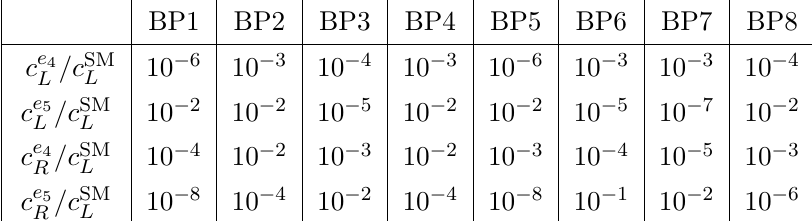
Table 3. Suppression factors of the VL lepton-gauge boson couplings w.r.t. the SM